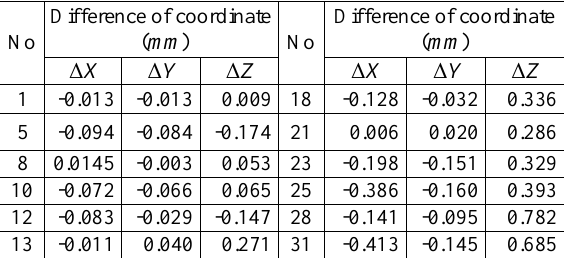
Table 5. Difference of check points object coordinates(six control points) From Table5, the mean square error of three directions are m X